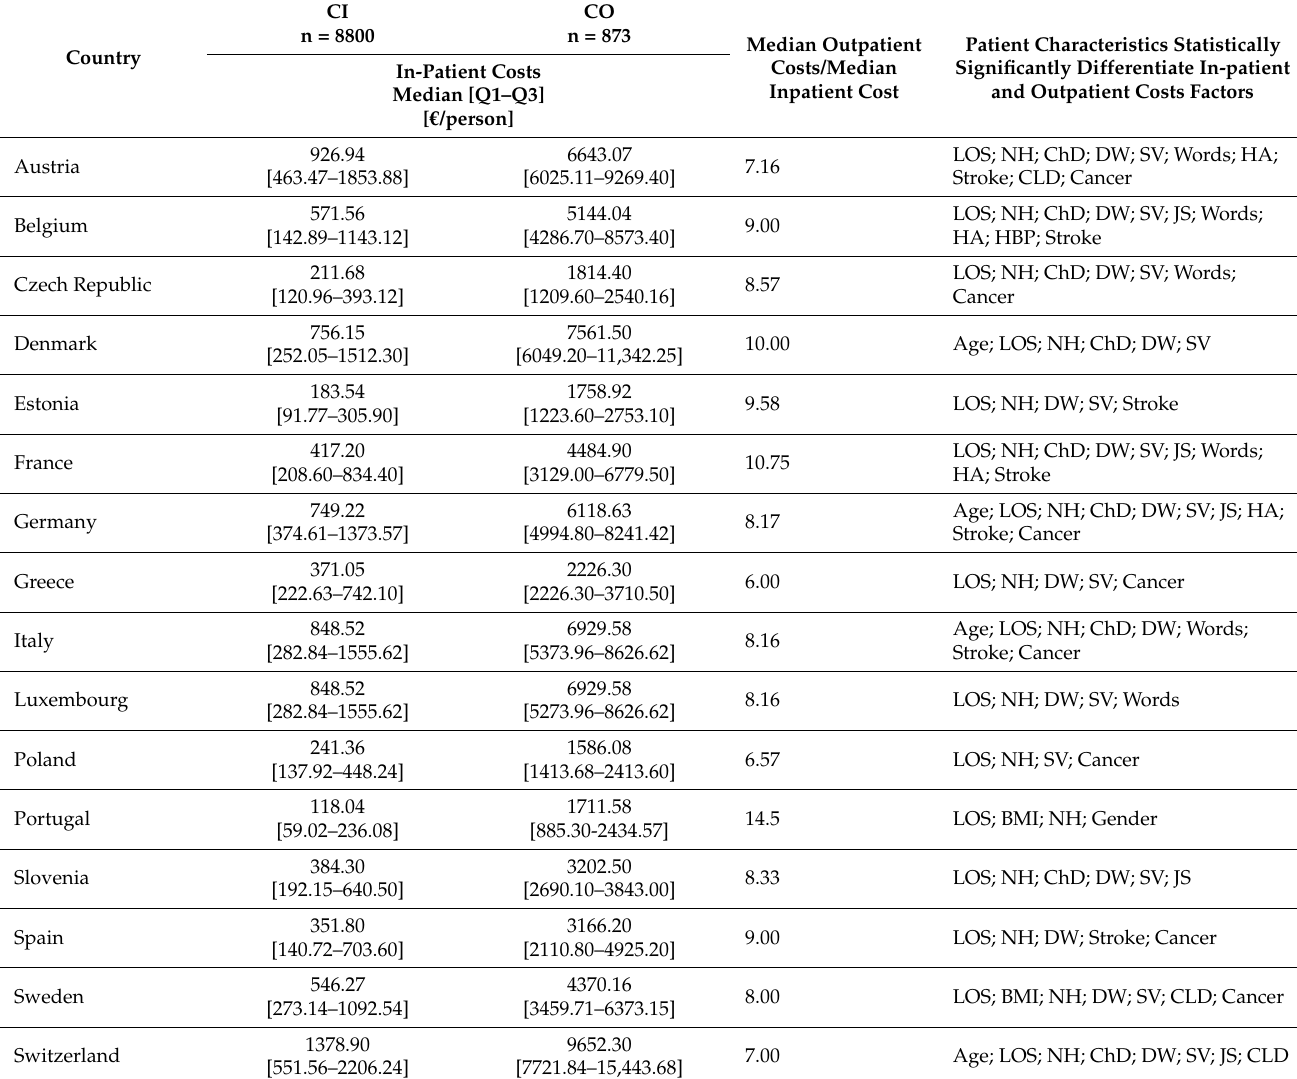
Table 3. Characteristics of cost outliers (CO) and inliers (CI) by